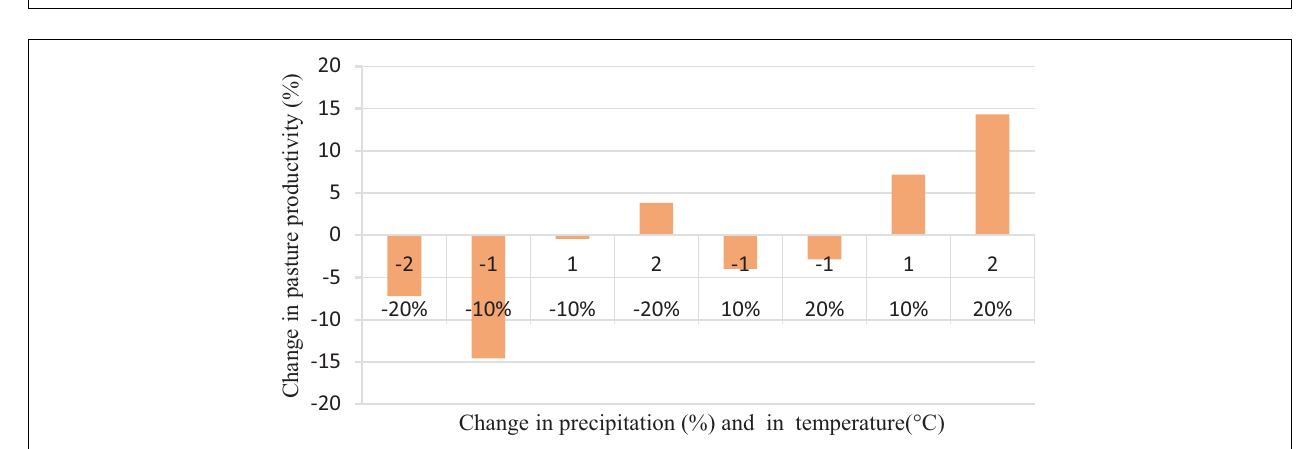
FIGURE 10 | The compared graph of temperature changes on pasture productivity.